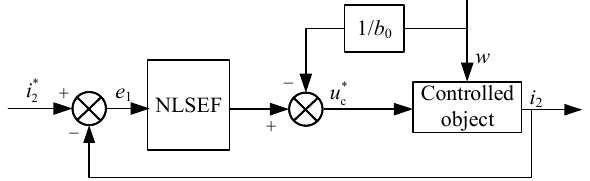
Figure 3. Simplified active disturbance rejection control block Figure 3. Simpli fi ed active disturbance rejection control block diagram.